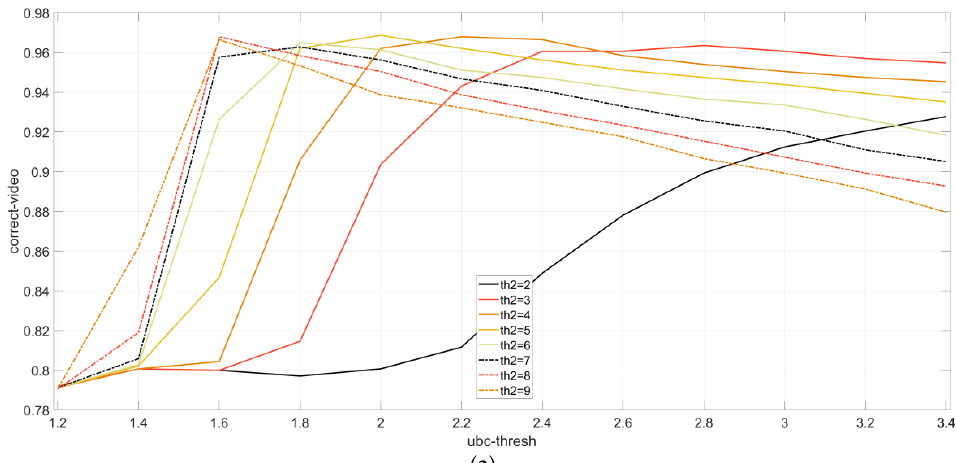
Figure 16. The experimental results with the control group. ( a ) Video searching; ( b ) Shot searching.